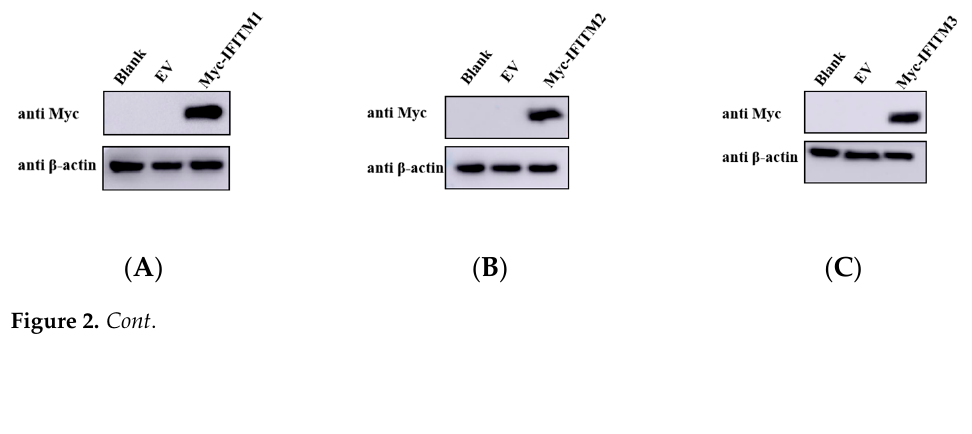
Figure 1. ( A ) HEK293 cells were cultured in 6 − well plates. When cells grew to a dense monolayer, cells were treated with di ff erent concentrations of IFN α− 2a (0, 500, 1000, 1500 IU/mL) for 12 h. Cells were collected and lysis with RIPA for IFITM proteins detection with a speci fi c antibody. β− actin served as an internal control. ( B ) Greyscale analysis was used to measure the protein expression level of IFITM proteins relative to β− actin. ( C ) HEK293 cells were cultured in 6 − well plates. When cells grew to a dense monolayer, cells were treated with di ff erent concentrations of IFN α− 2a (0, 500, 1000, 1500 IU/mL) for 12 h. Cells were collected, and cellular RNA was extracted for IFITMs mRNA detection via RT − qPCR. ( D ) HEK293 cells were cultured in 6 − well plates. When cells grew to a dense monolayer, cells were infected with 0.001 MOI EMCV for 6, 12, and 24 h. Cells were collected and lysis with RIPA for IFITM proteins detection with a speci fi c antibody. β− actin served as a loading control. ( E ) Greyscale analysis was used to measure the protein expression level of IFITM proteins relative to β− actin. ( F ) HEK293 cells were cultured in 6 − well plates. When cells grew to a dense monolayer, cells were infected with 0.001 MOI EMCV for 24 h. Cells were collected, and cellular RNA was extracted for IFITMs’ mRNA detection via RT − qPCR. Data were expressed as mean ± SDs from three independent experiments and were measured in technical duplicate. Comparisons be- tween groups were performed using the Student’s t − test. *** p < 0.001, ** p < 0.01.